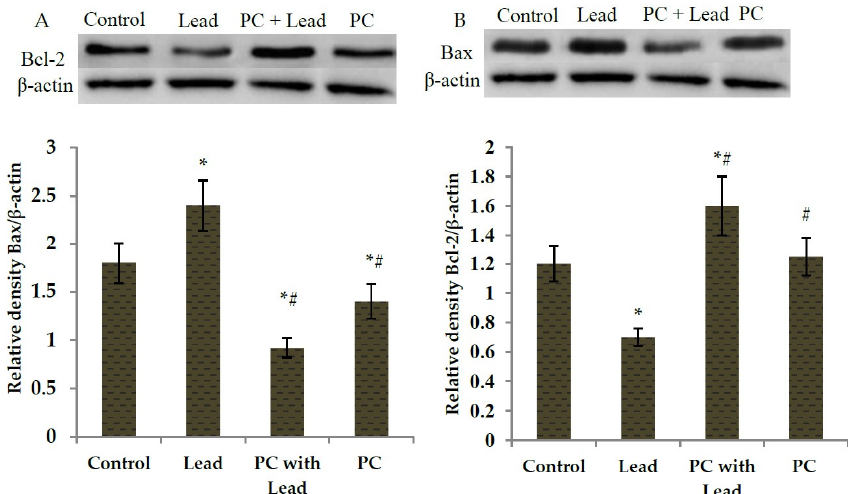
Figure 4. The effect of proanthocyanidins (PCs) on the protein expression levels of Bcl-2 and Bax in the liver of mice exposed to lead. ( A ) Bcl-2; ( B ) Bax. All results are expressed as the mean ± SE ( n = 7). * p < 0.05, significant change with respect to the control; # p < 0.05, significant change with respect to lead-treated